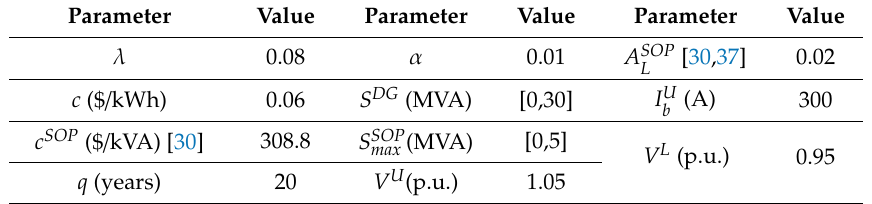
Figure 4. Real 83-node distribution system in Taiwan. Table 1. Input data configurations.